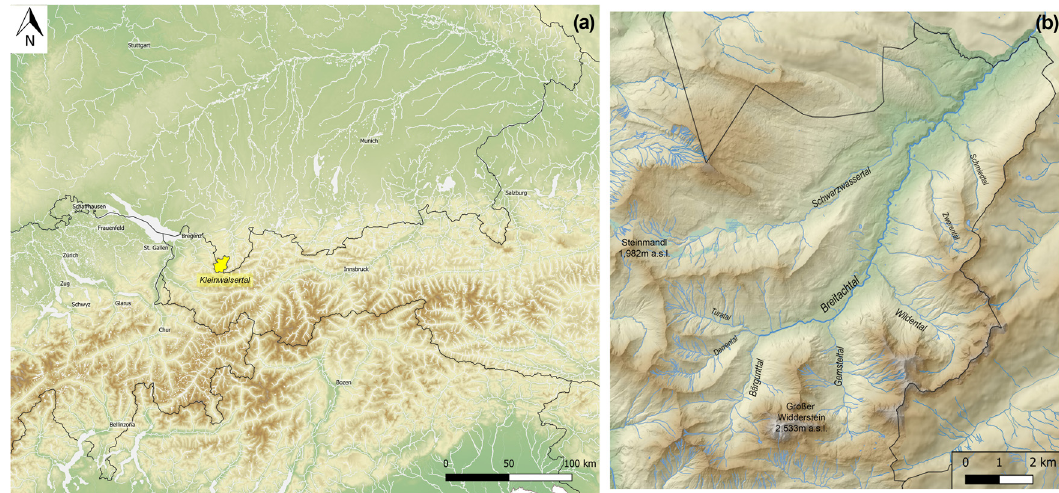
Figure 1: ( a ) Position Kleinwalsertal ( yellow ) in Southern Central Europe and ( b ) regional topography and layout. Data source: Land Vorarlberg – data.vorarlberg.gv.at – 5 m DEM; Copernicus eu_dem_v11_E40N20 – 25 m